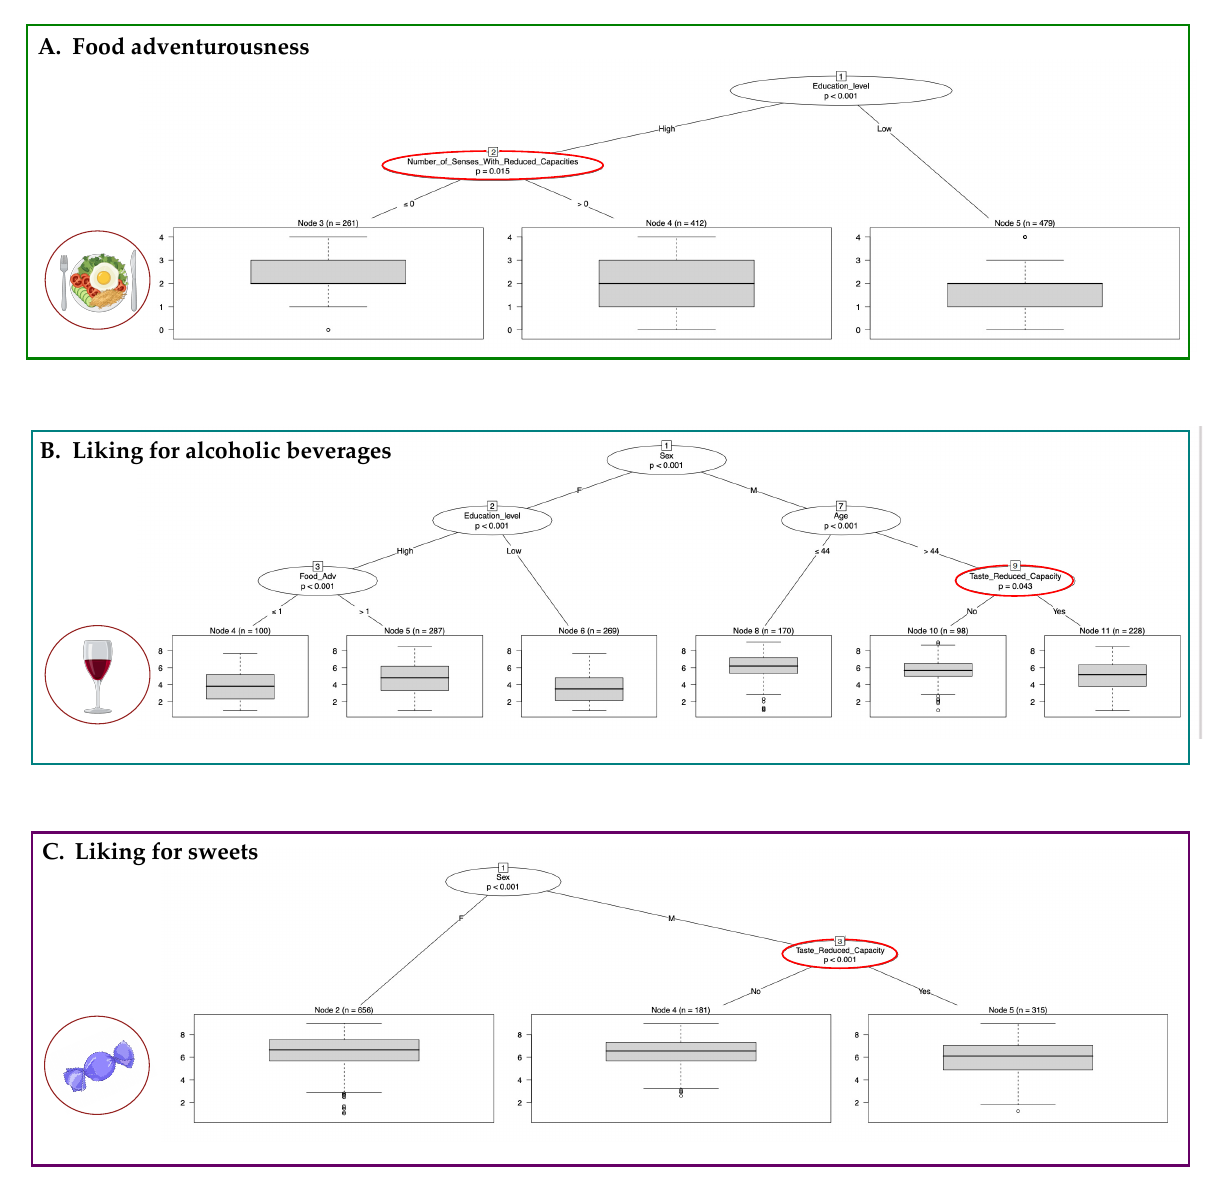
Figure 5. Binary trees, computed by conditional recursive partitioning, of the effect of the number of senses with reduced capacities and reduced capacity in hearing, smell, and taste, together with gender, age, food adventurousness, and education level, on food adventurousness ( A ), liking for alcoholic beverages ( B ), and liking for sweets ( C